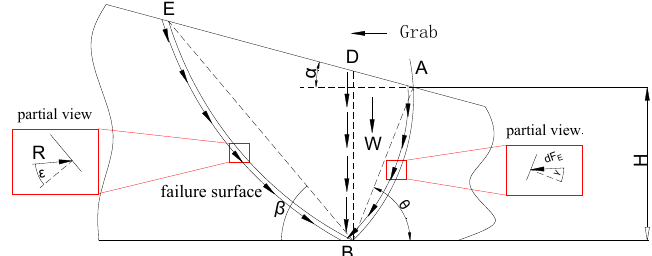
Figure 5. Force diagram of material body under passive pressure.